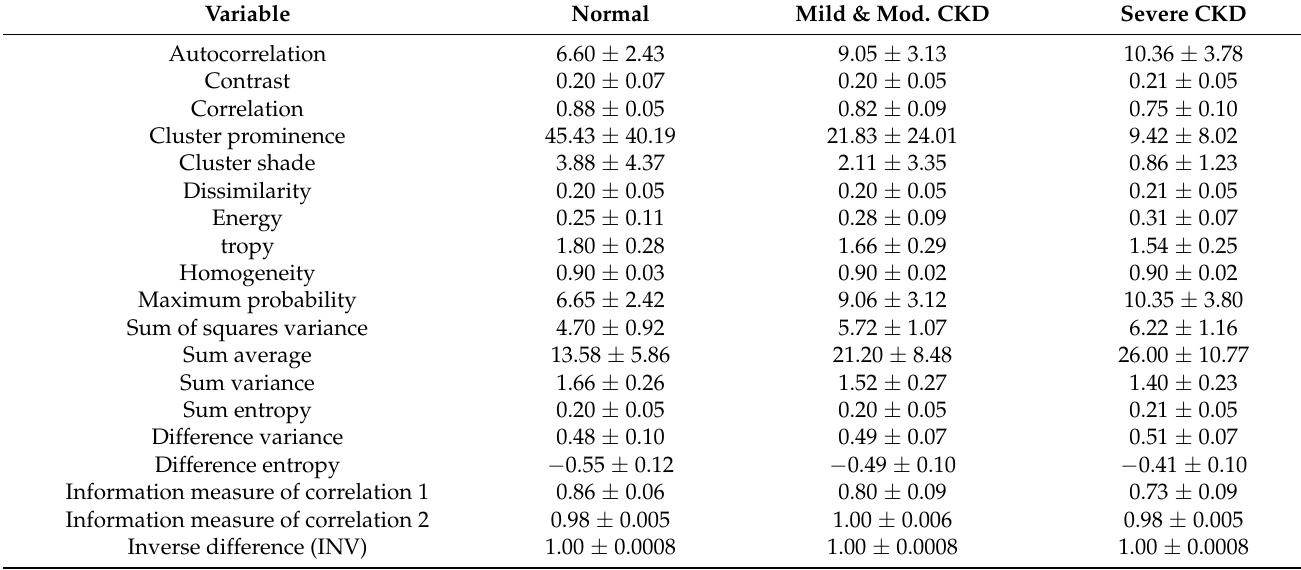
Table 5. Values of GLCM features of the boundary between the cortex and medulla (mean ± STD).